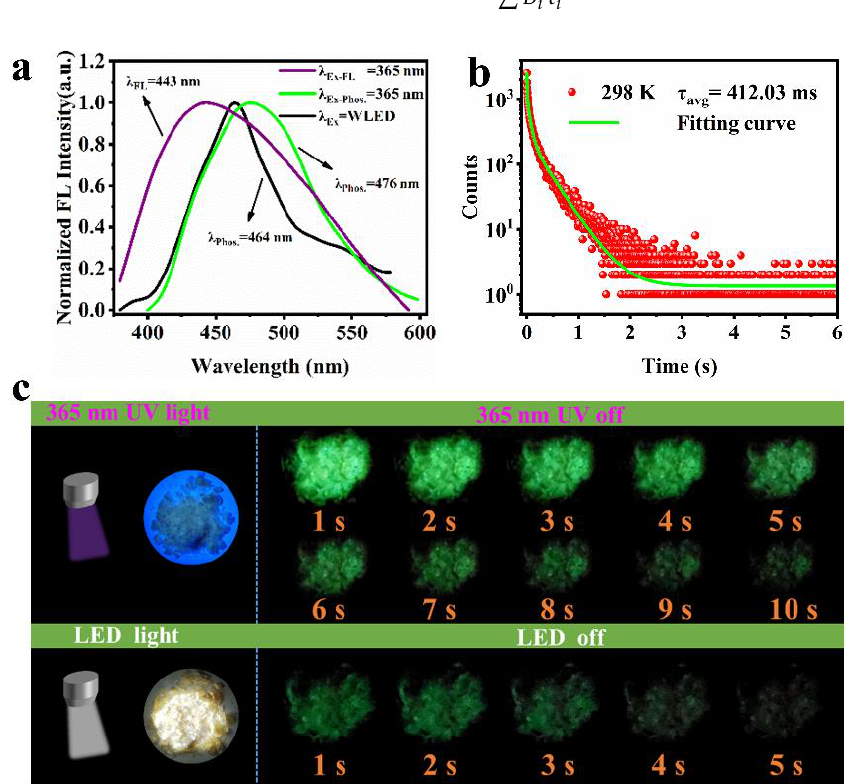
Figure 5. ( a ) FL and afterglow emission spectra of AA-CPDs at 365 nm and WLED. ( b ) Afterglow lifetime of AA-CPDs at 365 nm excitation. ( c ) Images of AA-CPDs powders under UV 365 nm and WLED on and off with time.